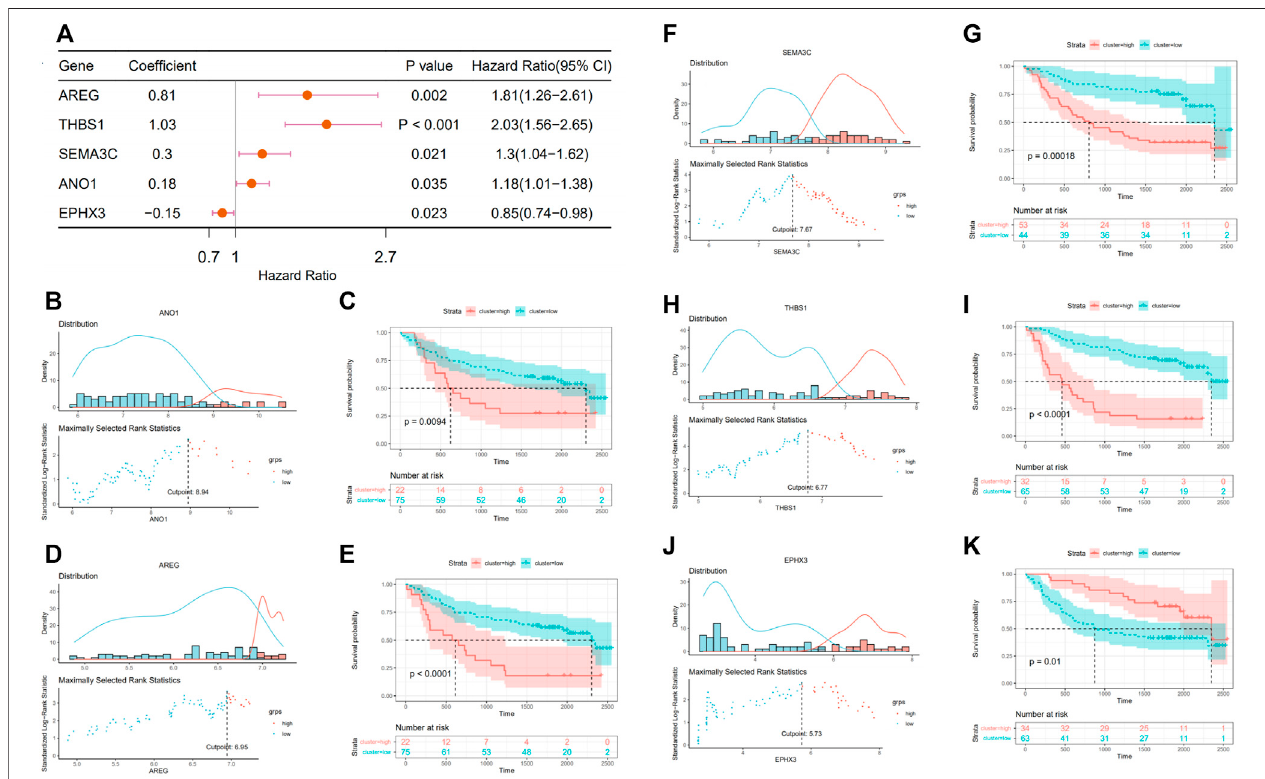
FIGURE 6 | Validation in external data set (GSE416130). (A) Forest plot of the prognostic effects of fi ve genes in prognostic model on a univariate Cox regression analysis. (B,D,F,H,J) A vertical dashed line was used to mark the cutoff point with the maximum standard log-rank statistic based on the expression of each gene. (C,E,G,I,K) Kaplan – Meier plot established the survival differences between high (high expression of target gene) and low (low expression of target gene) groups.